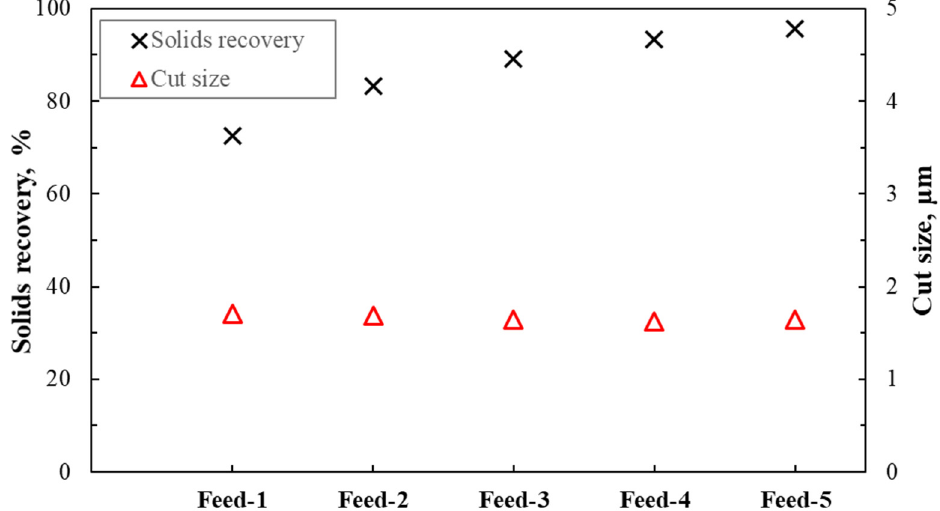
Figure 12. Solids recoveries and cut sizes of the SBC with different feeds of different particle size distributions.